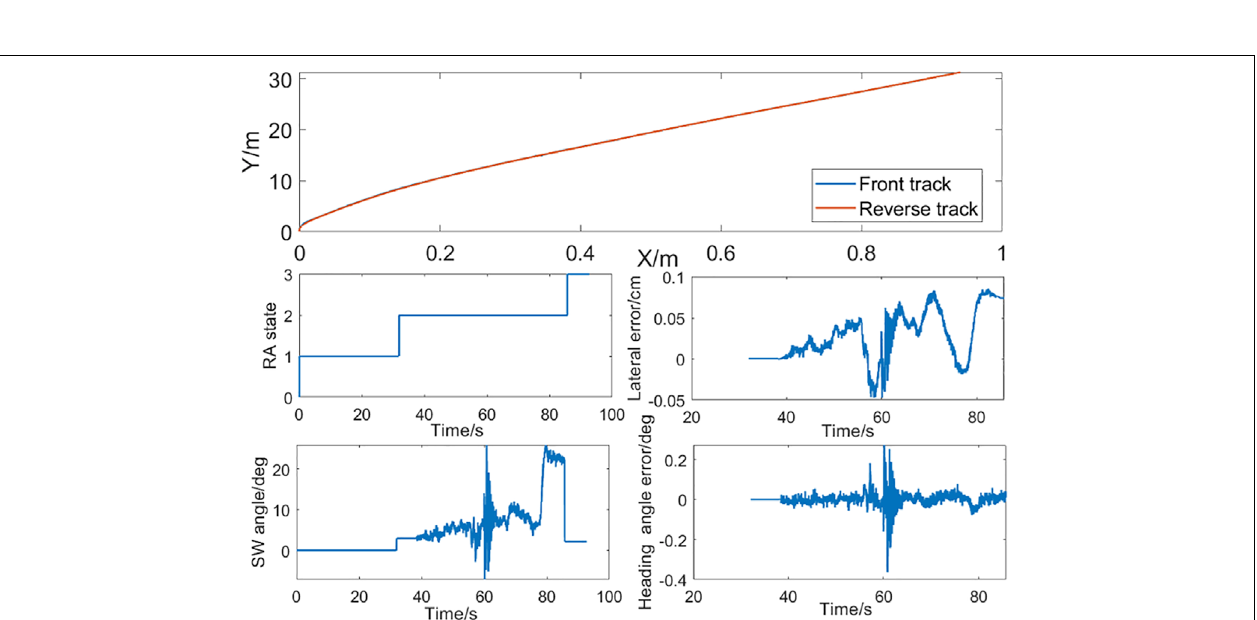
FIGURE 12 | RA in a speed